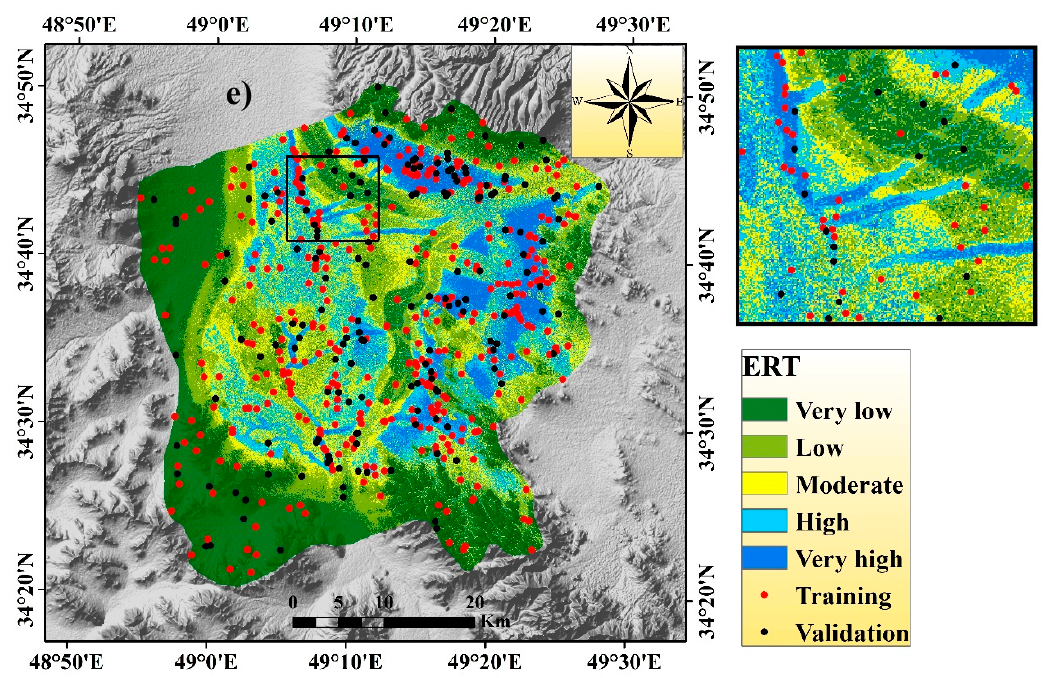
Figure 4. Flash flood susceptibility map using the five models: ( a ) Boosted regression tree (BRT), ( b ) random forest (RF), ( c ) parallel random forest (PRF), ( d ) regularized random forest (RRF), and ( e ) extremely randomized trees (ERT). Table 2. Flash flood susceptibility classes’ areas.